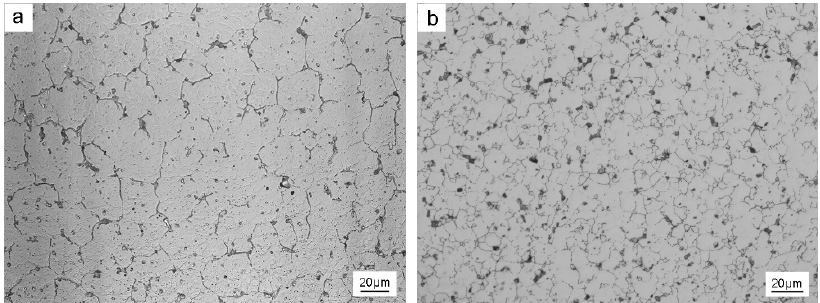
Figure 4. Images showing the metallographic structures of ( a ) Al-Mg alloy deposits and ( b ) Al-Mg-0.3Sc alloy deposits.